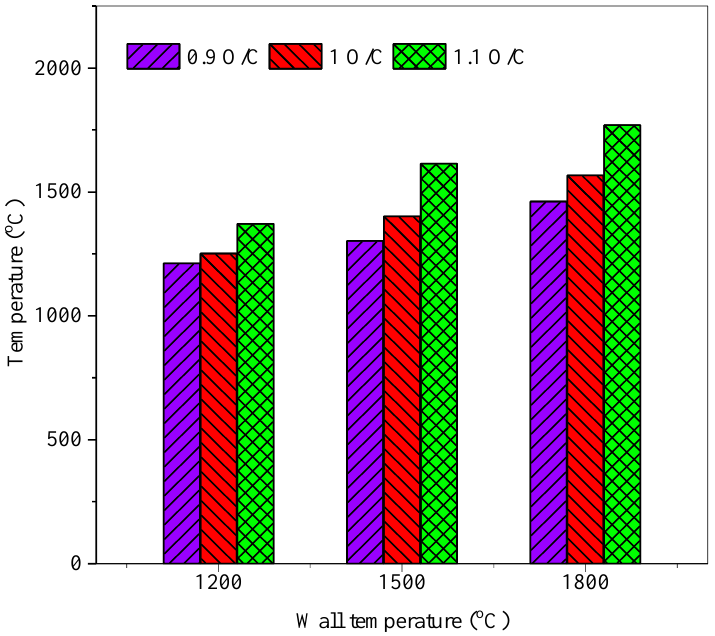
Figure 7. Syngas temperature for numerous cases at the exit of the furnace.